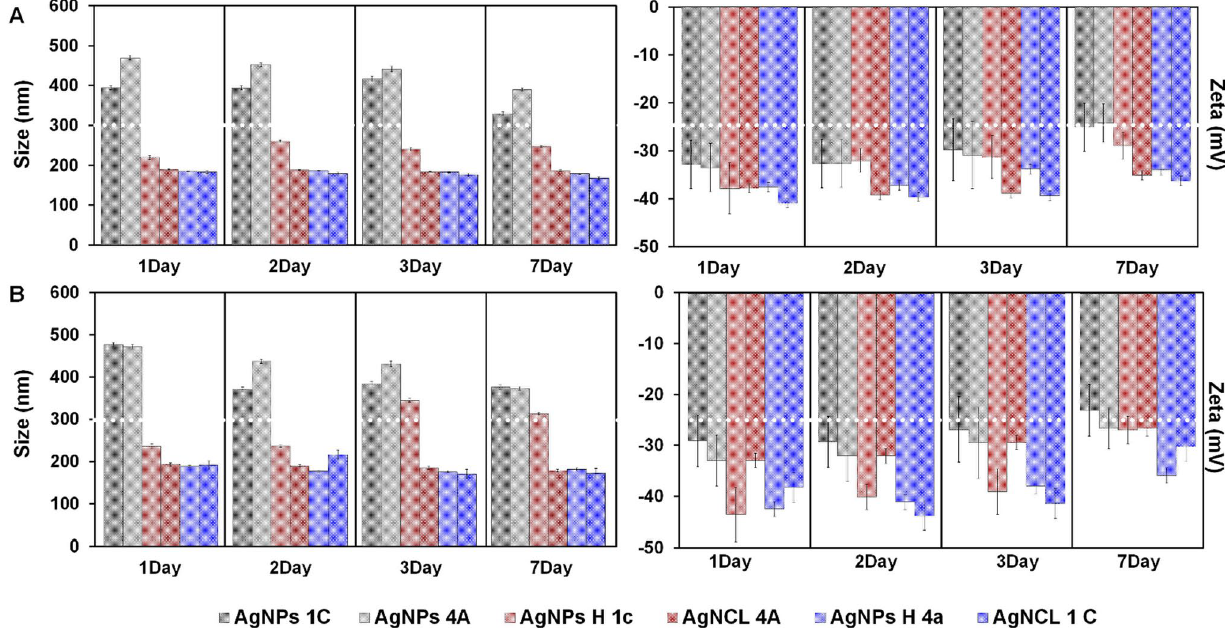
Fig. 7 A profile of Size and Zeta potential values presenting the hydrodynamic diameter and the stability of the all synthesized (Bio)NCs types during 7 days at 12.5 µg/mL ( A ) and 25 µg/mL ( B